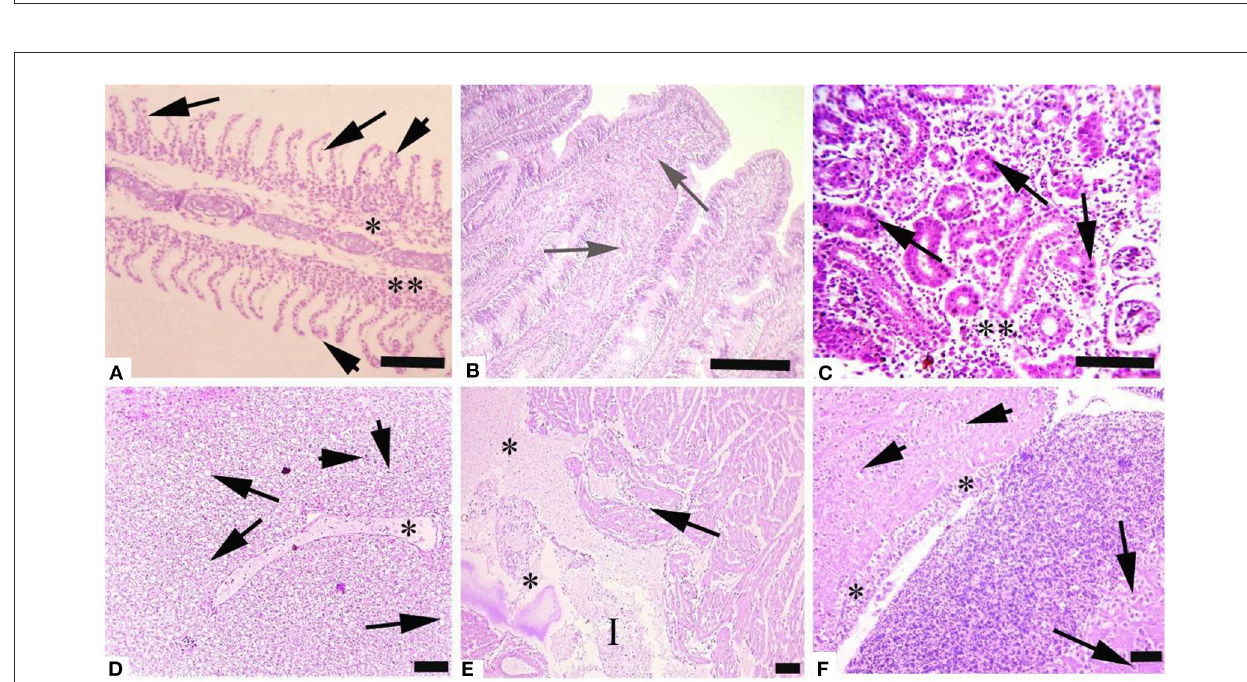
FIGURE2 Photomicrograph of different tissues of freshwater fish treated with CuSO 4 (0.56 µ g.L − 1 ) at experimental day 36: (A) Gills showing aneurysm (arrowheads), disorganization of primary lamellae (double asterisk) and necrosis of epithelium of secondary lamellae (arrows), (B) Intestine showing hemorrhages (arrows), (C) kidneys showing necrosis of renal tubules (asterisk) and necrosis of tubular epithelial cells (arrows), (D) Liver showing edema (asterisk), vacuolar degeneration (arrows) and necrosis (arrowheads), (E) Heart showing disorganization of cardiac muscles (arrow), edema (asterisks) and inflammatory exudate (I) and (F) Brain showing necrosis of neurons (arrowheads), degeneration of neurons (arrows) and microgliosis (asterisk). H and E. Bar is equal to (A) and (E) = 50 µ m, and (B–D) and (F) = 100 µ